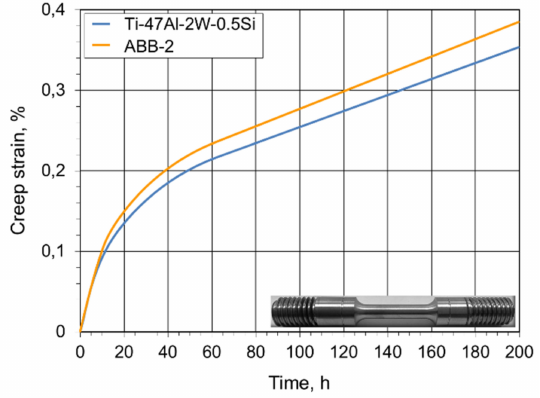
Figure 12. Creep strain vs. time for Ti-47Al-2W-0.5Si alloy tested at 760 ◦ C and 207